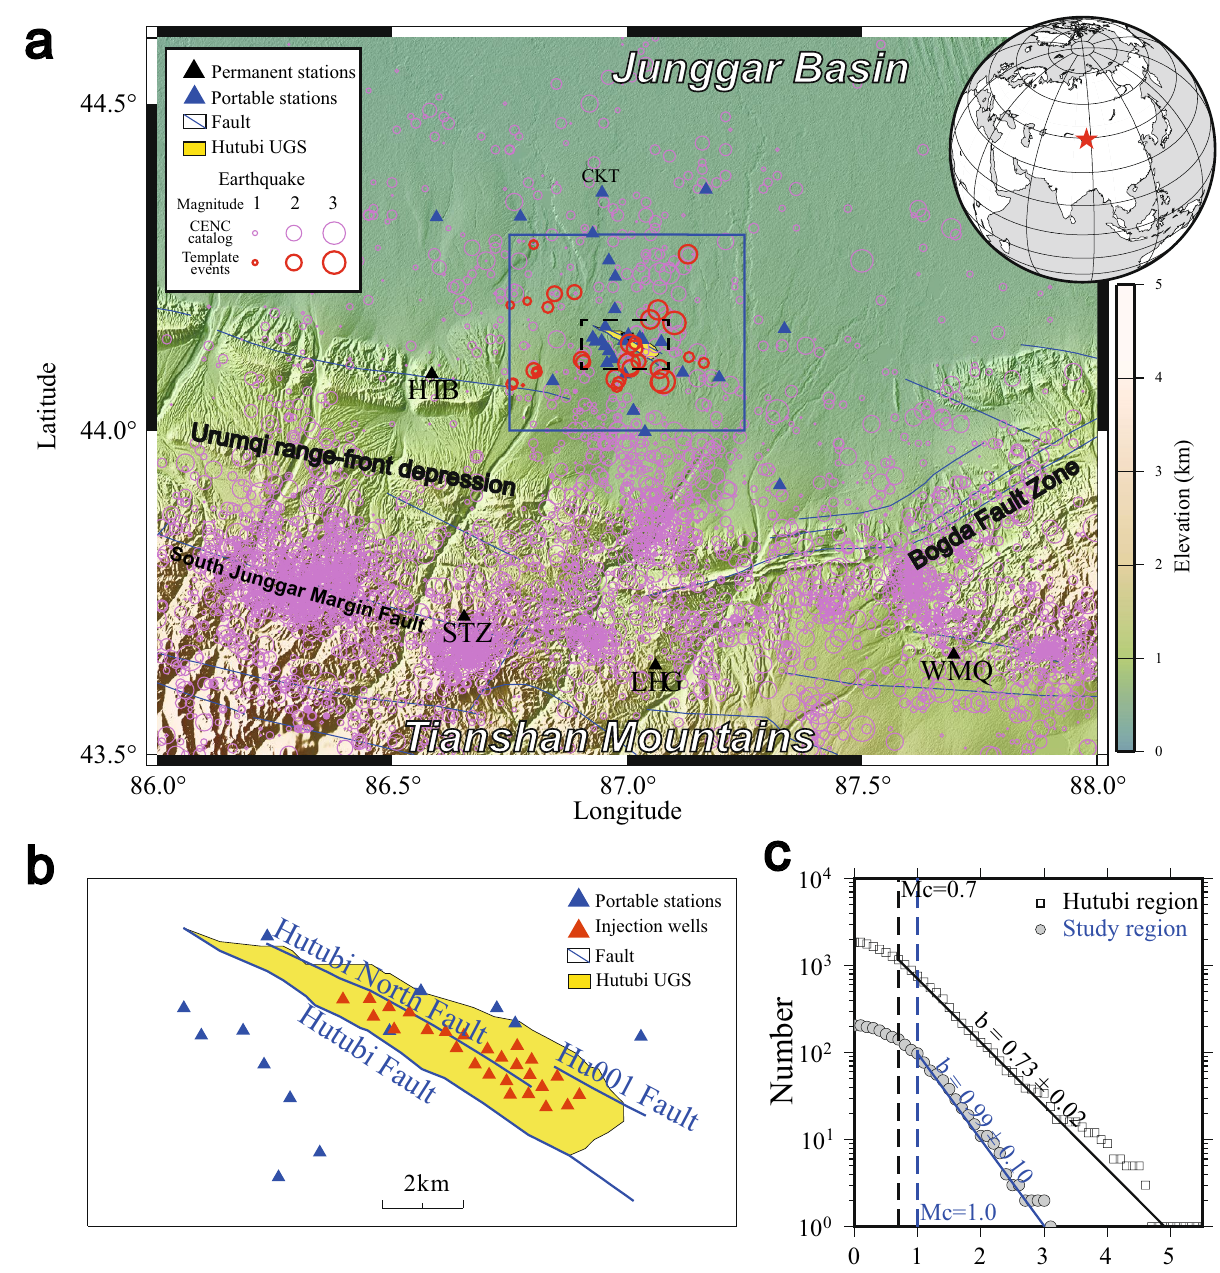
Figure 1. ( a ) Map of the study region. Portable and permanent seismic stations are marked with blue and black triangles, respectively. The yellow area is the surface projection of the Hutubi underground gas storage (UGS) facility. The blue rectangle encompasses the study area. The pink and red cycles show the earthquakes reported by the China Earthquake Networks Center and the relocated template events, respectively. The blue lines show the major faults in the region. ( b ) Detailed representation of the area around the Hutubi UGS, corresponding to the dashed rectangle in ( a ). The blue and red triangles are portable seismic stations and injection wells, respectively. ( c ) The cumulative number of earthquakes versus magnitude is fit to the Gutenberg-Richter relation to estimate the M C and the b-value. (The elevation data is the 90 m topography from the Shuttle Radar Topography Mission 31 , this figure was created with the Generic Mapping Tools (GMT) 5.4.4, URL: www. gener ic- mappi ng- tools.